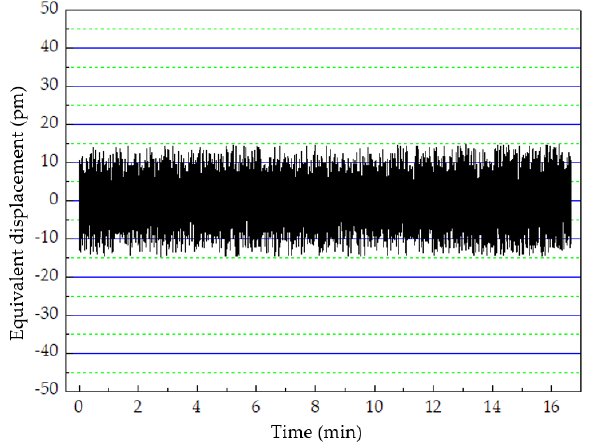
Figure 8. The noise impact on the measurement of position drift.